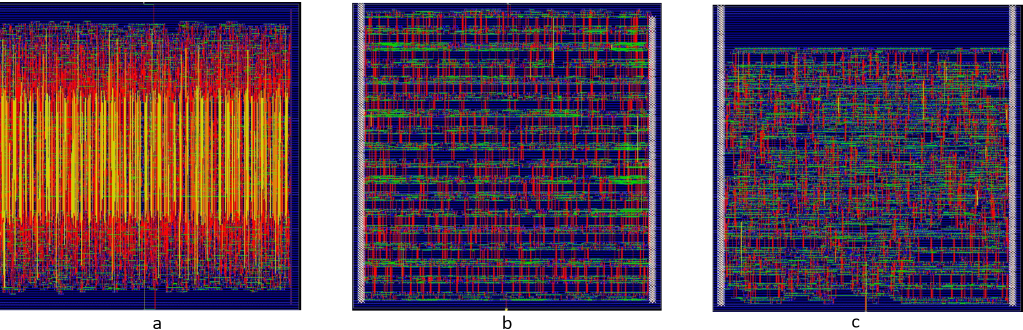
Figure 4. Routing of the 3 different implementation strategies: ( a ) 3Blocks ( b ) Interleaved ( c ) Improved interleaved.